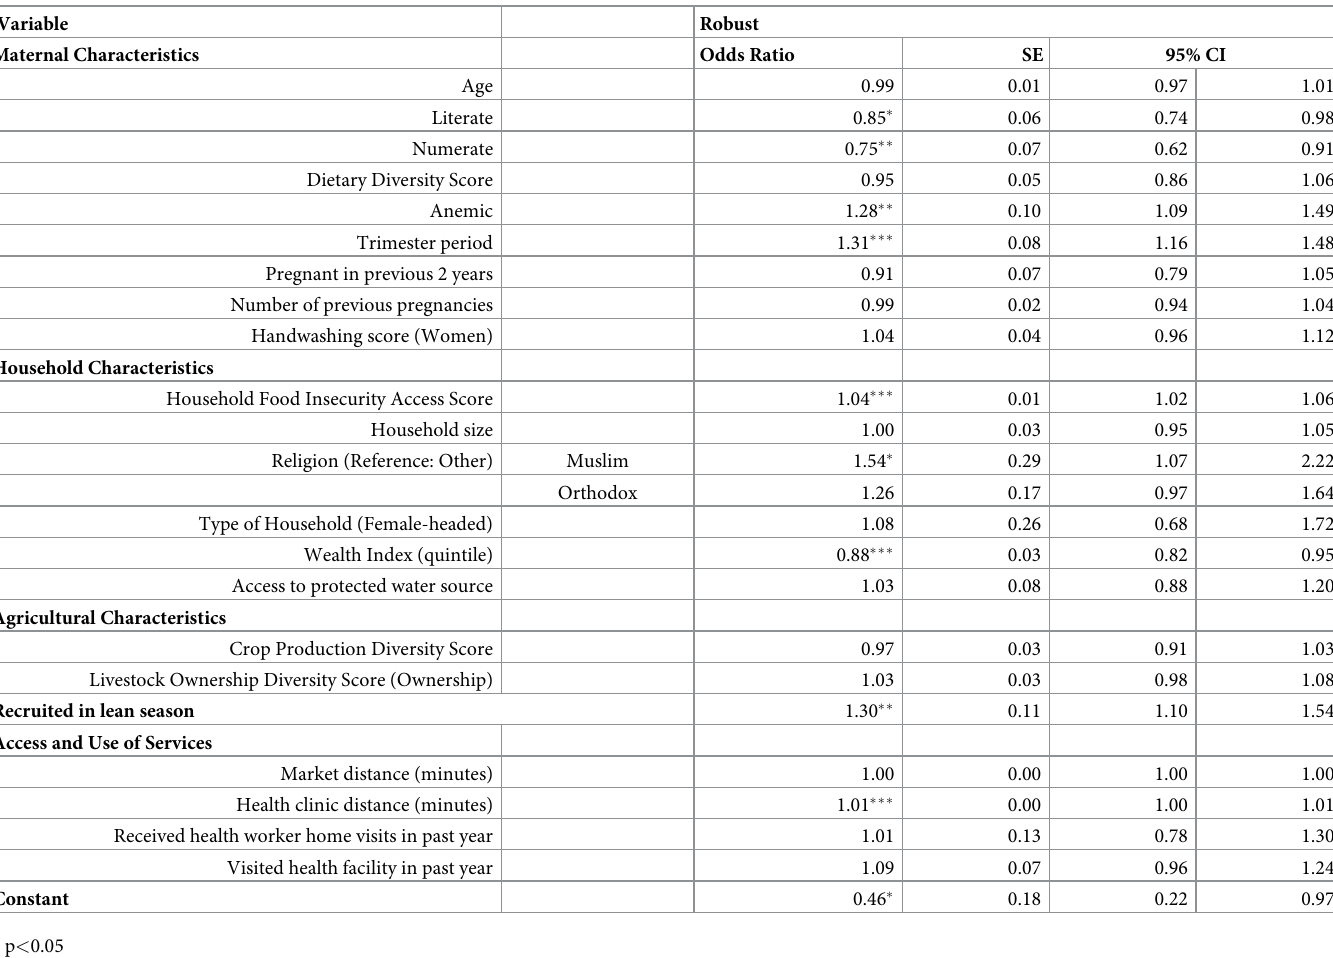
Table 2. Factors associated with low MUAC (n =